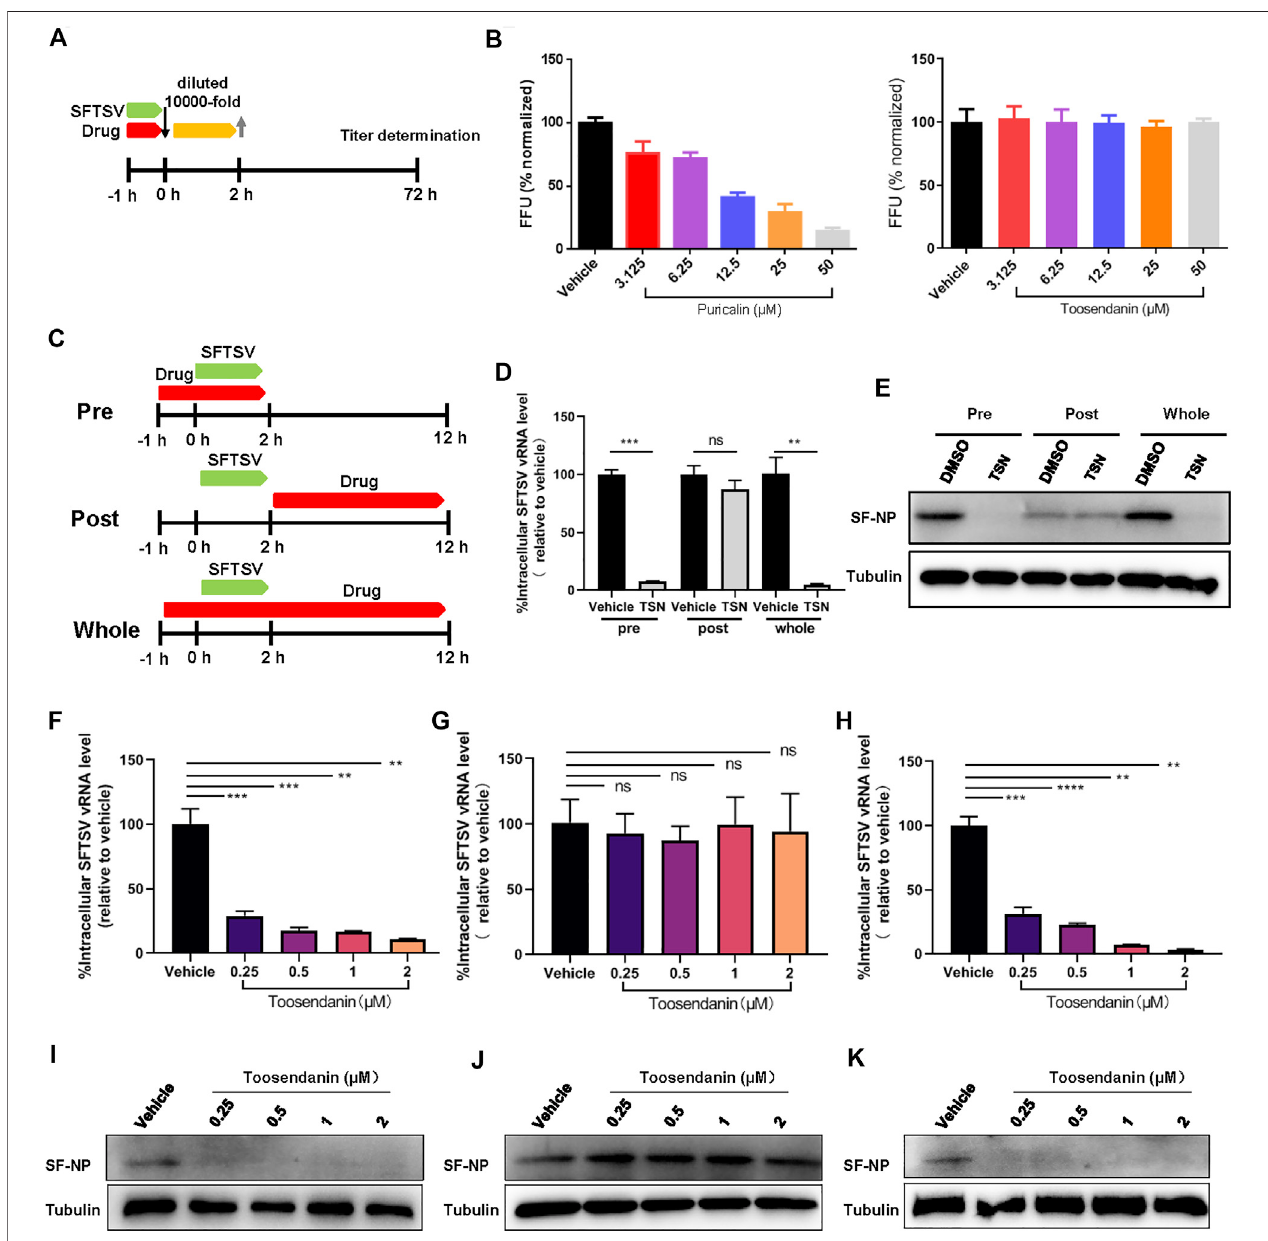
FIGURE3 | Toosendanin inhibits the entry step of SFTSV infection. (A) Schematic diagram of the virucidal effect assay. (B) The virucidal effect of punicalin and toosendanin. SFTSV was incubated with indicated concentrations of punicalin and toosendanin for 37 ° C for 1 h. The mixture was diluted 10,000 fold and subjected to titer determination. (C) Schematic diagram of time-of-addition assay of toosendanin. (D,E) HUVEC cells infected with SFTSV at an MOI of 2 for 2 h were treated with toosendanin (1 μ M) for 1 h pre-infection (pre), post-infection (post), and whole time (whole). Infected cells were collected at 12 h post infection for viral RNA quanti fi cation (D) and western blot (E) . (F – K) Time-of-addition assay was conducted under the indicated concentrations of toosendanin. The inhibitory effect of toosendanin on pre (F,I) , post (G,J) , and whole (H,K) were determined by qRT-PCR and western blot. TSN, toosendanin. Data shown are means ± SD ( n (cid:1) 3). Comparison of mean values (D,F,G,H) between two groups were analyzed by Student ’ s t test. ** p < 0.01; *** p < 0.001; **** p < 0.0001; ns, no signi fi cance.